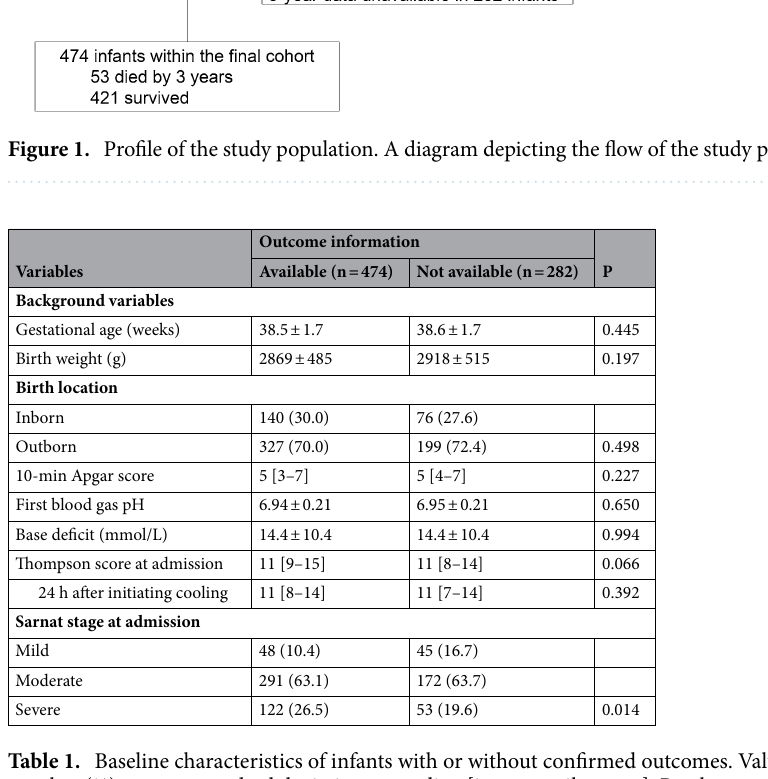
Table 1. Baseline characteristics of infants with or without confirmed outcomes. Values are shown as the number (%), mean ± standard deviation or median [interquartile range]. P-values were determined via Student’s t-test (unpaired, two-tailed), Mann–Whitney U-test or Chi-square test, without correction for multiple